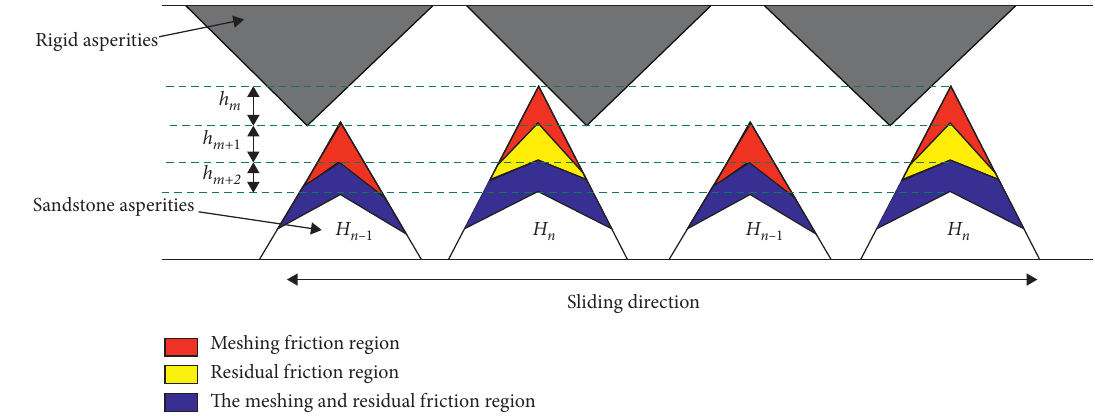
Figure 2: Schematic diagram of the asperities wear